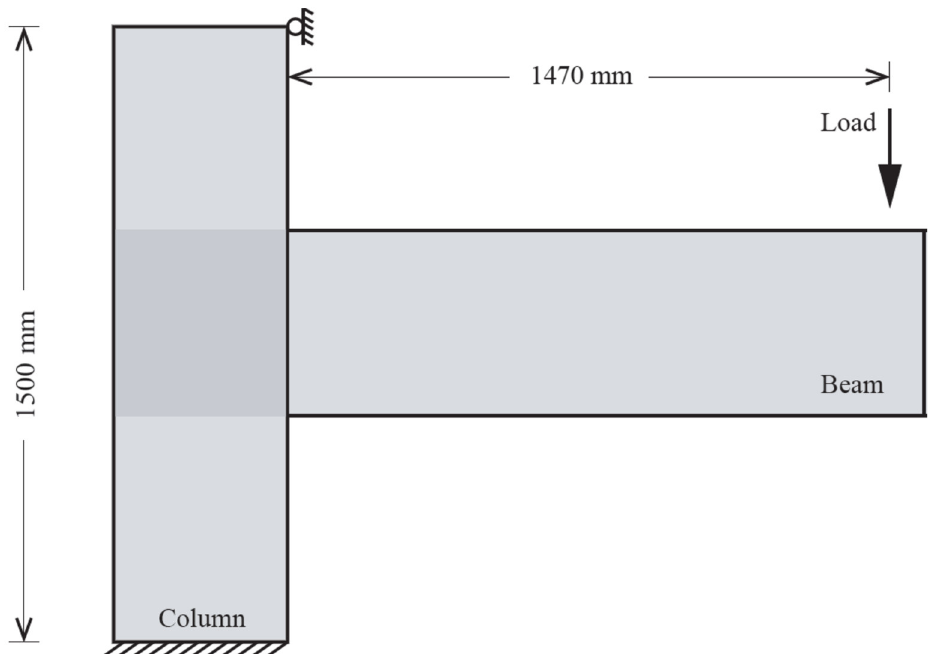
Figure 9. Sketch of loading and boundary conditions.